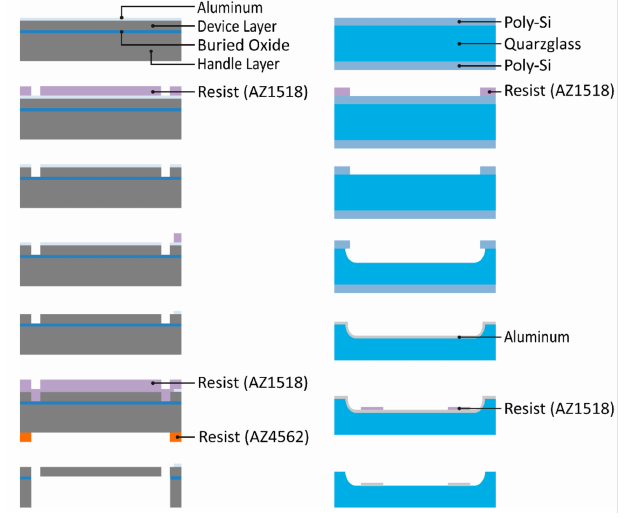
Figure 3. Graphical flowchart of the device chip ( left ) and the counter electrode chip ( right ).